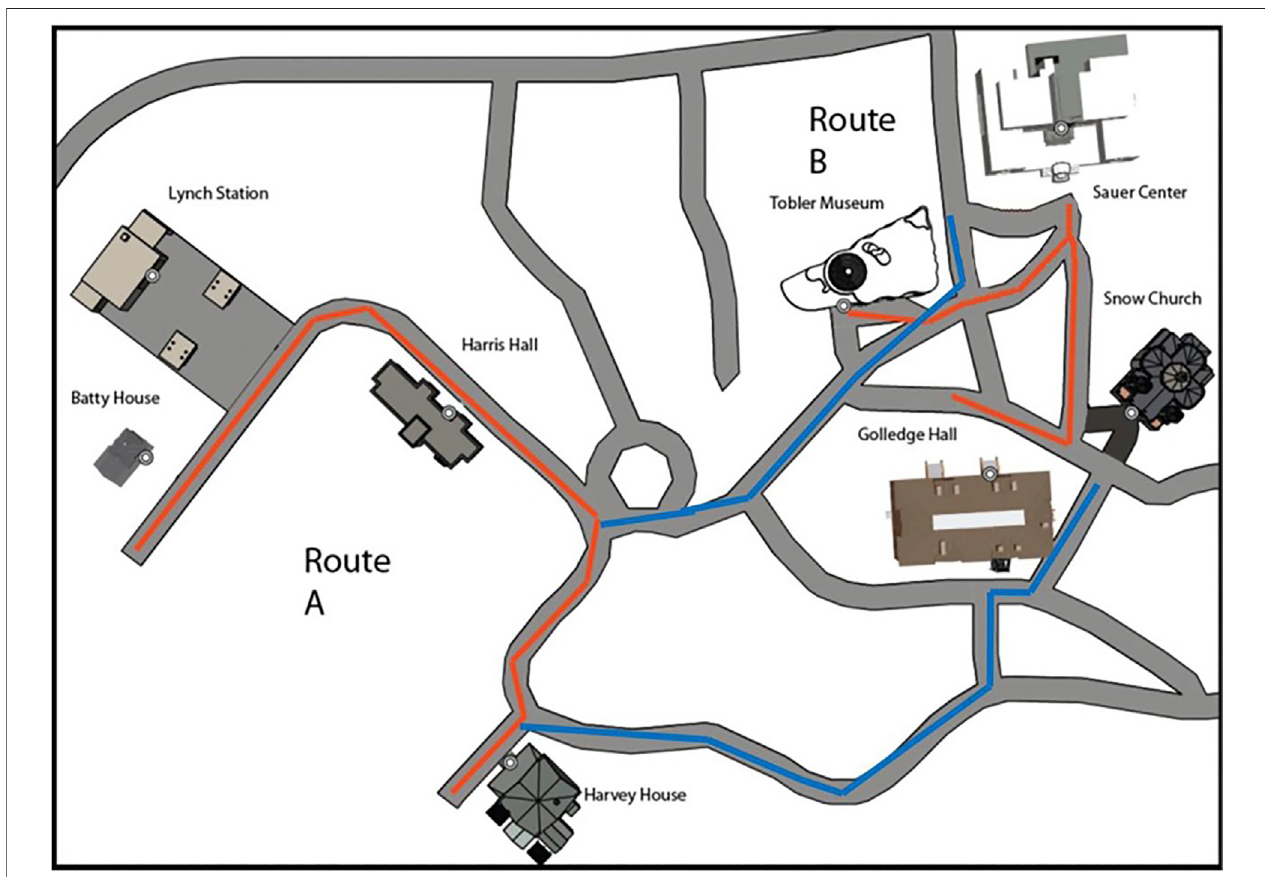
FIGURE 1 | Overhead view of the Silcton environment including the two main routes A (in red or lighter gray that connects Batty House, Lynch Station, Harris Hall, and Harvey House) and B (in red or lighter gray that connects Tobler Museum, Sauer Center, Snow Church, and Golledge Hall) and the two connector routes (in blue or darkergray).From “ VariationsinCognitiveMaps: UnderstandingIndividualDifferencesinNavigation, ” byS.M.Weisberg,V.R.Schinazi, N.S.Newcombe, T.F. Shipley, and R. A. Epstein, 2014, Journal of Experimental Psychology: Learning, Memory, and Cognition, 40 (3), 671. Copyright 2013 by the American Psychological